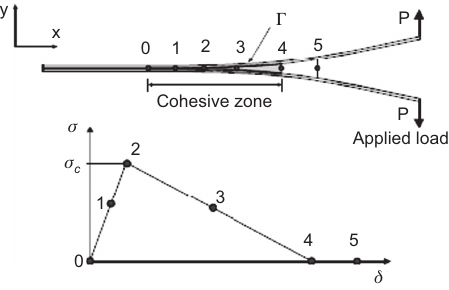
Figure 3 Cohesive zone ahead of the delamination